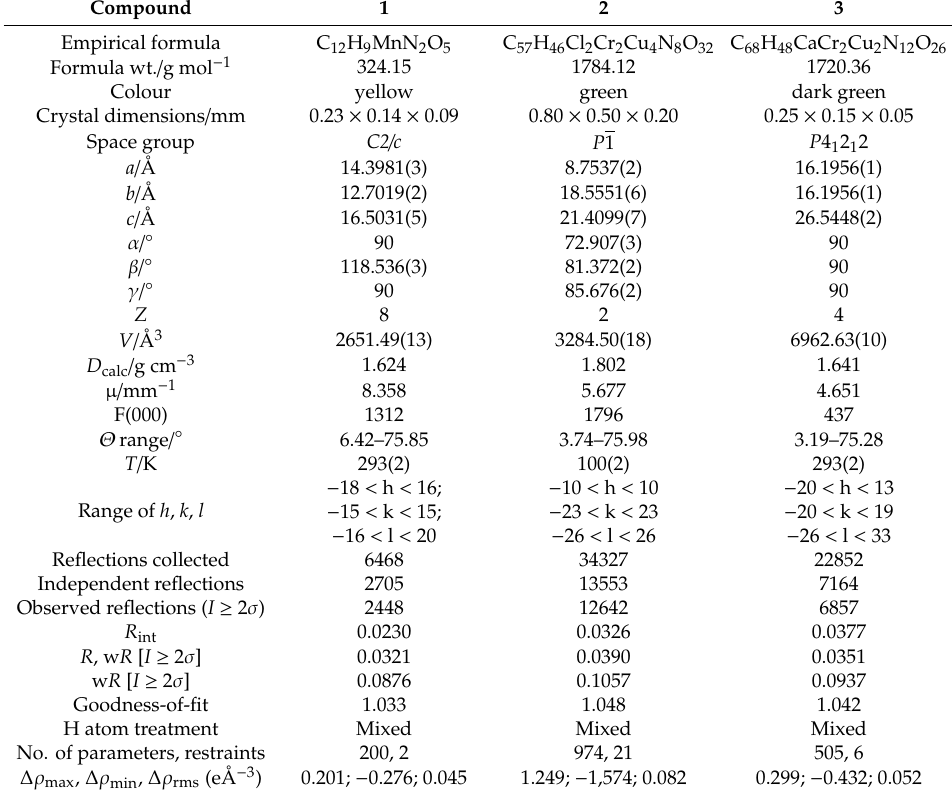
Table 1. Crystallographic data and structure refinement details for compounds 1 – 3